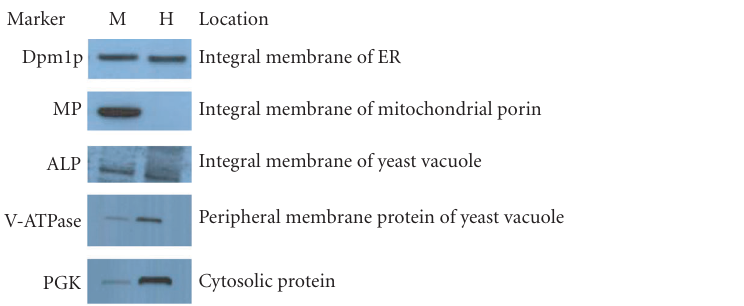
Figure 4. Partitioning of solubilized yeast membrane proteins using the Mem-PER Kit. Yeast proteins from S cerevisiae (strain: EGY- 194) were solubilized and partitioned based on hydrophobic phase separation. Several proteins were solubilized and extracted using the Mem-PER reagents. Partitioning e ffi ciency was determined through Western blot of normalized samples. A negligible amount of protein was found in all debris fractions (data not shown). Abbreviations: mitochondrial porin (MP), 3-phosphoglycerate kinase (PGK), alkaline phosphatase (AP), Dol-P-Man synthase (Dpm1p), M = solubilized membrane protein, H = hydrophilic protein frac- tion.